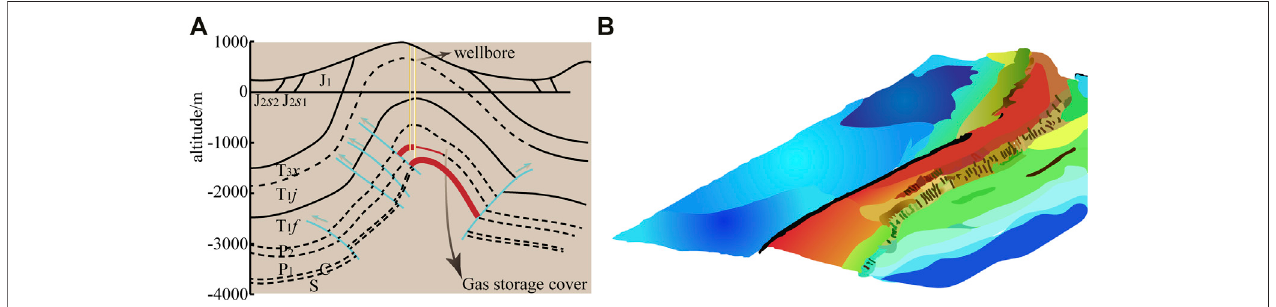
FIGURE 2| Xiangguosi reservoir and tectonic structure. (A) schematic diagram of the tectonic section of Xiangguosi; (B) reservoir map of Xiangguosi gasstorage.